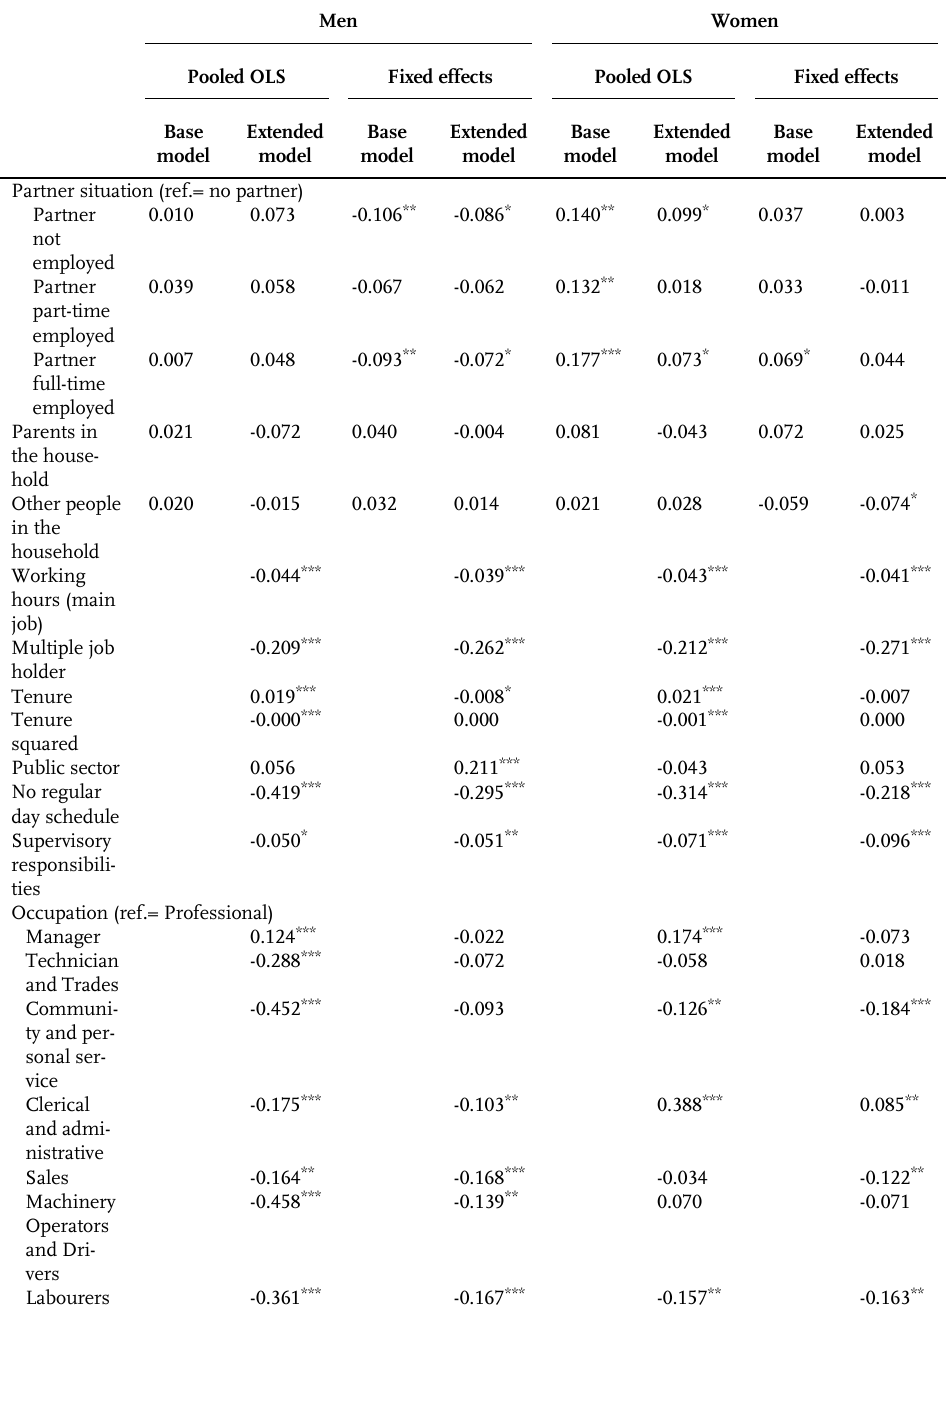
Table A.3 : Employment types and WLB (full models) (continued)